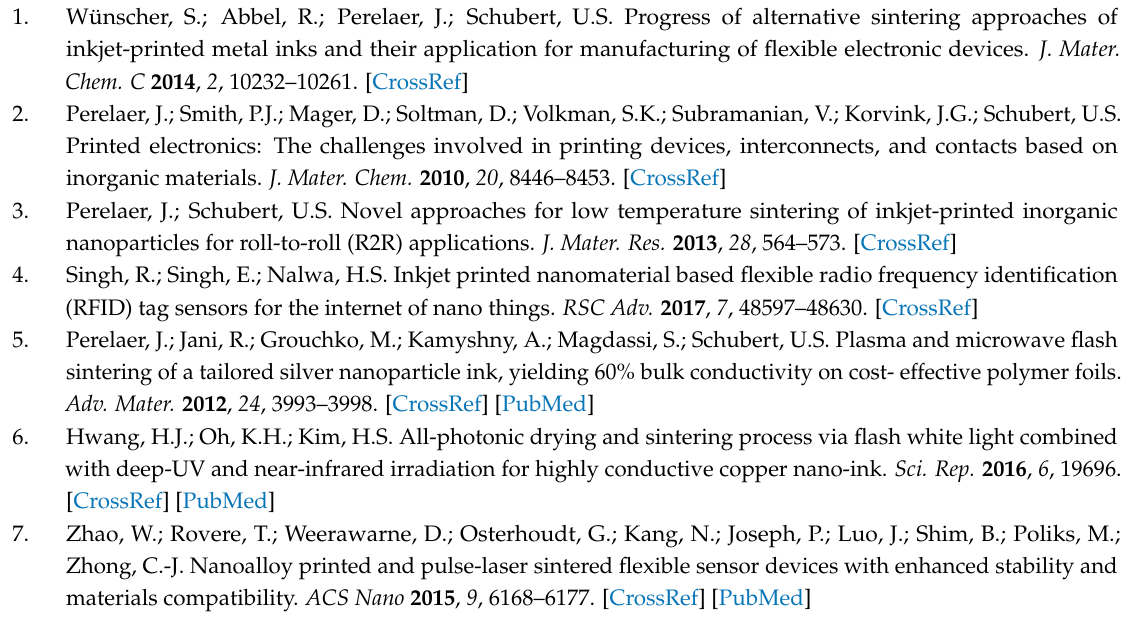
Figure S1: schematic images for preparing test film of (a) liquid ink and (b) paste ink, Figure S2: XRD patterns of samples for copper nitride, copper(II) oxide, and copper(I) oxide after IPL sintering, Figure S3: appearance of samples prepared from liquid ink including CuO before and after IPL sintering, Figure S4: schematic image for forming hollow particles, Figure S5: XRD patterns of different vehicles including Cu 3 N films after IPL sintering, Figure S6: appearance of a sample film after IPL sintering front side and back side, Figure S7: XRD patterns of sample films including CuO and Cu 2 O after IPL sintering, Figure S8: cross-section SEM image of the sample sintered by IPL at 8.30 J cm − 2 of irradiation